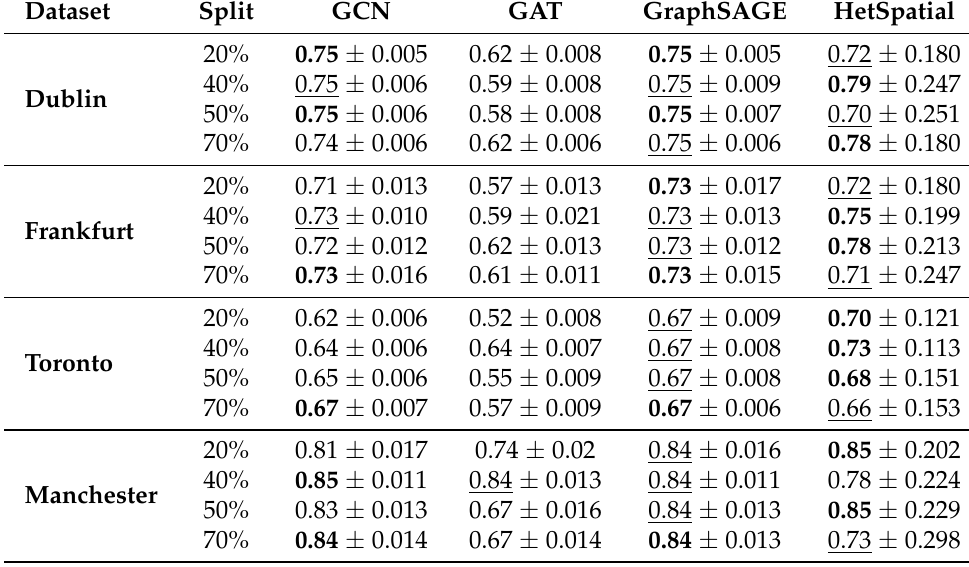
Table 7. Table showing the micro F1-score results for street type inference. The values in bold and underlined represent the best and second best performing approaches for each city/split,